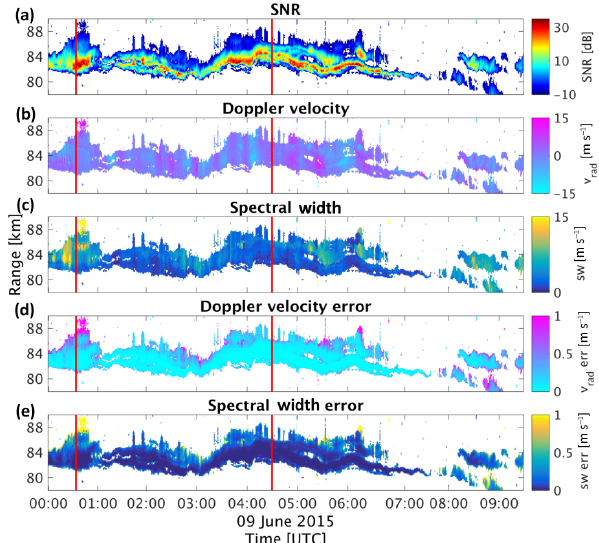
Figure 3. Analysed parameters of the narrow beam (3.6 ◦ ). (a) SNR: the PMSE was strong during the observation time but got weaker in the last 2h. (b) Doppler velocity: the radial velocity varies be- tween ± 15ms − 1 . (c) The spectral width appears to be increased sometimes at the top of PMSE (00:00–01:00UTC) or in the whole PMSE (08:00–09:00UTC). (d) Doppler velocity error: error of the radial velocity estimation from the Gaussian fit. (e) Spectral width error: error of the width estimation from the Gaussian